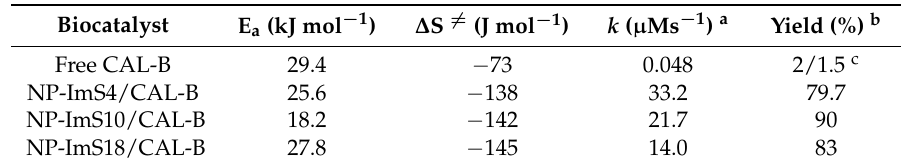
Table 1. Thermodynamic and kinetic parameters of the activation energy and entropy associated to the transesterification reaction yield for free and immobilized CAL-B.